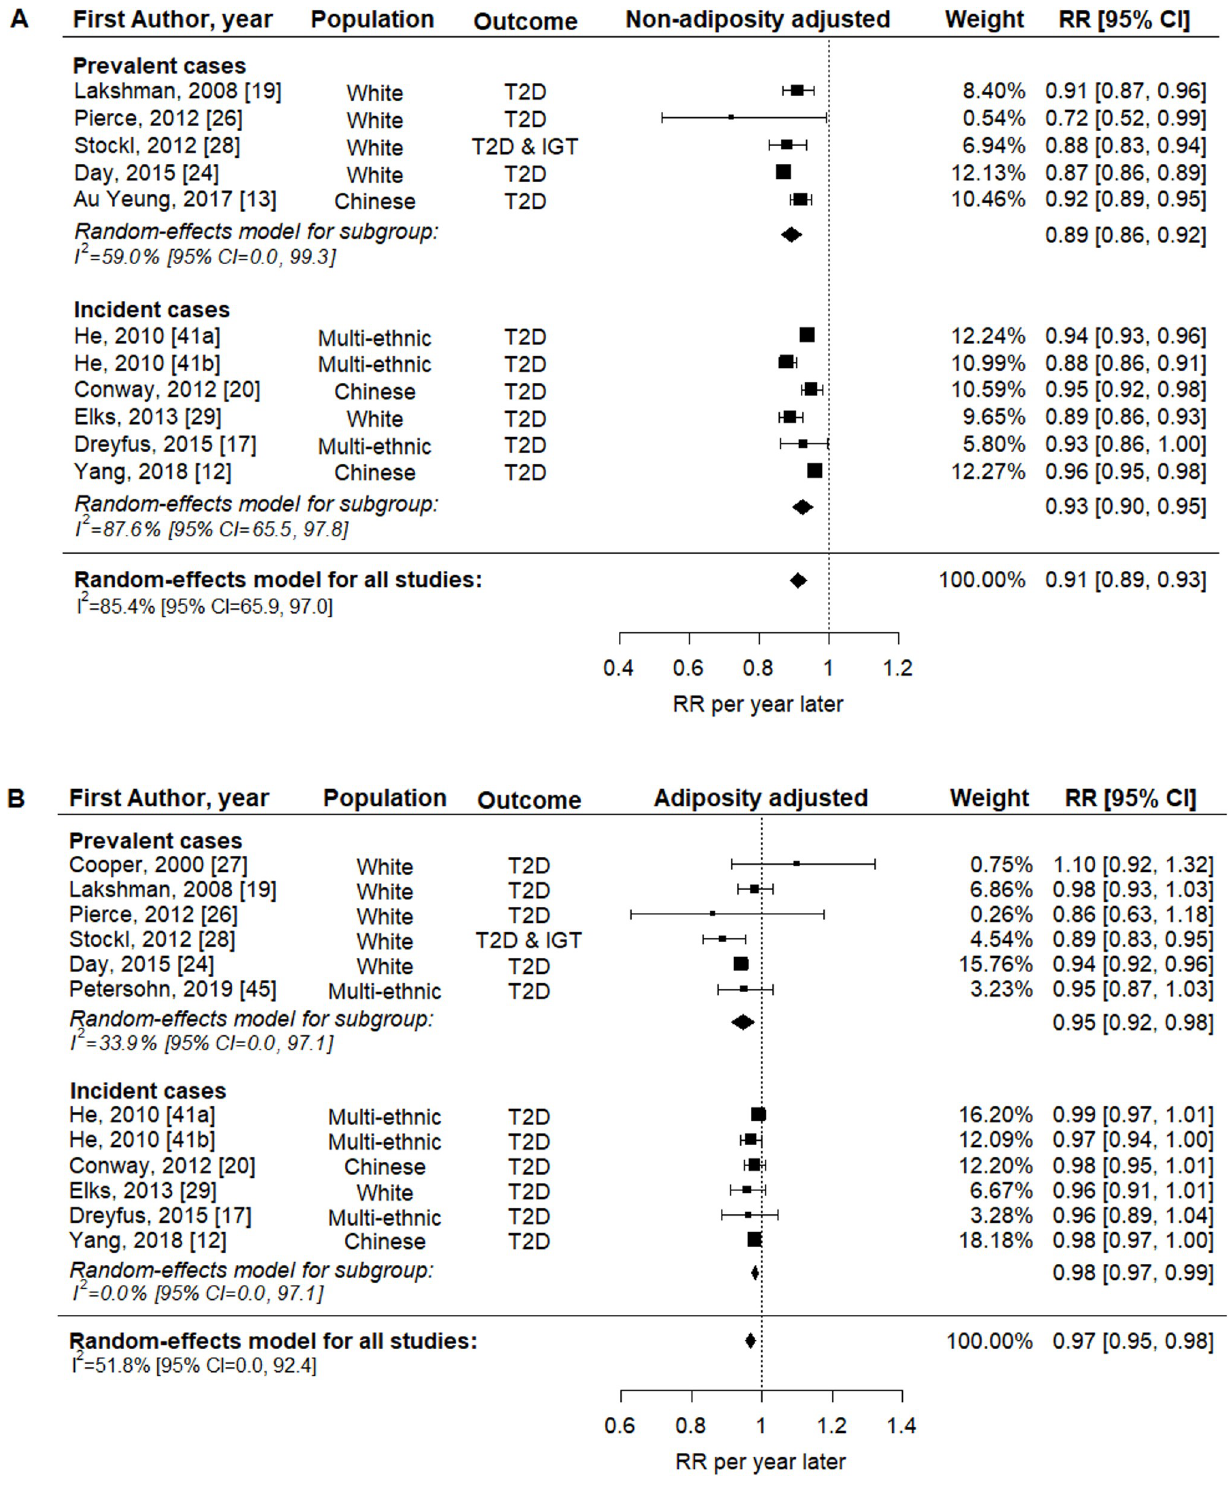
Fig 2. Forest plots of the association between AAM (continuous variable) and T2D/IGT, without and with adjustment for adiposity. (A) Without and (B) with adjustment for adiposity. Two cohort studies in He, 2010 [41]. AAM, age at menarche; IGT, impaired glucose tolerance; RR, relative risk; T2D, type 2